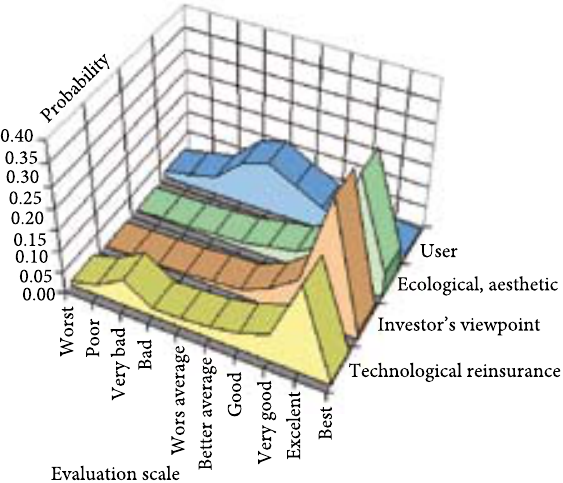
Fig. 6. Graph of a variant: concrete